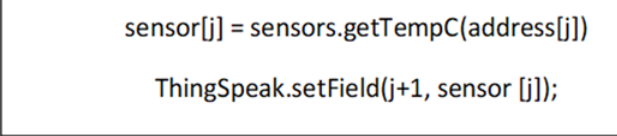
Figure 8. Reading and delivery of a temperature sensor.